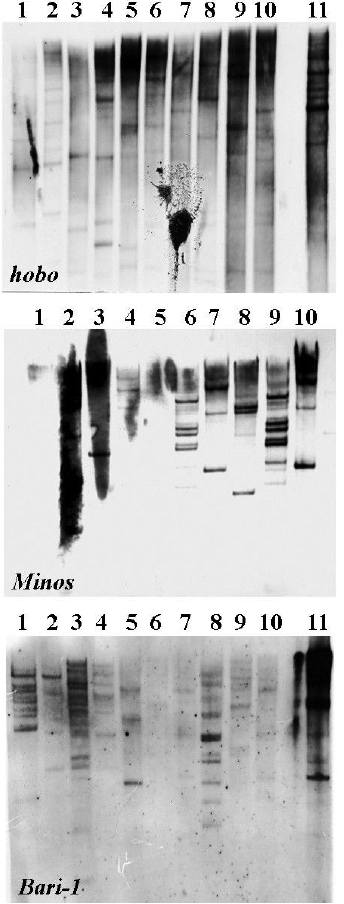
Figure 2 - Southern blot analysis of the transposons hobo , Minos and Bari-1 in D. neocordata (1); D. emarginata (2); D. parasaltans (3); D. subsaltans (4); D. milleri (5); D. dacunhai (6); D. sturtevanti (7); D. austrosaltans (8); D. saltans (9); D. prosaltans (10) and D. melanogaster